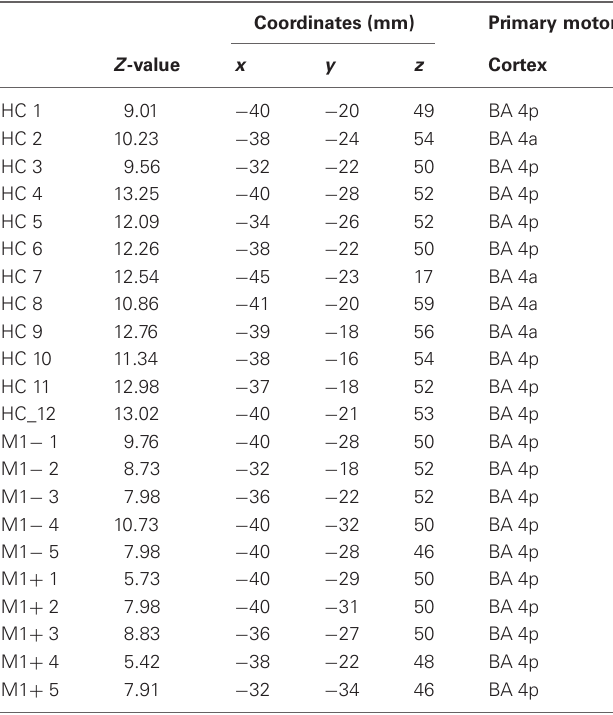
Table 3 | MNI coordinates and Z -value group statistics for most strongly activated voxel during hand motor localizer